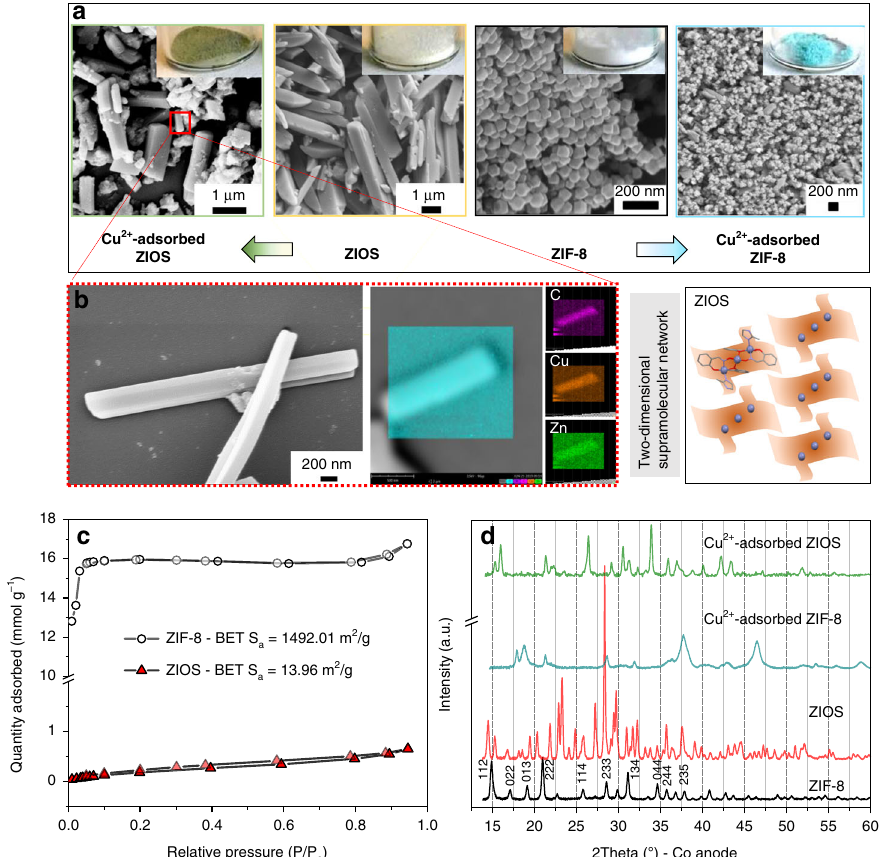
Fig. 2 Structural, chemical, and physical properties of ZIOS and ZIF-8 before and after adsorption. a SEM images and optical properties of ZIOS and ZIF- 8 before and after Cu 2 + adsorption. b An expanded SEM image and energy-dispersive X-ray spectroscopy (EDS) analyses with area-scan on ZIOS-Cu (note that the samples were loaded on a silicon wafer, which is a source of Si, O, and N); and a schematic diagram of a ZIOS network created by periodic stacking of two-dimensional trinuclear units. c N 2 adsorption and desorption isotherms and Brunauer – Emmett – Teller (BET) speci fi c surface areas (S a ) of ZIOS and ZIF-8. d PXRD data for ZIOS and ZIF-8 before and after 24-h exposure to aqueous Cu 2 + (425 ppm solution) at ambient conditions. ZIOS clearly retains a high degree of crystallinity following copper adsorption, in contrast to